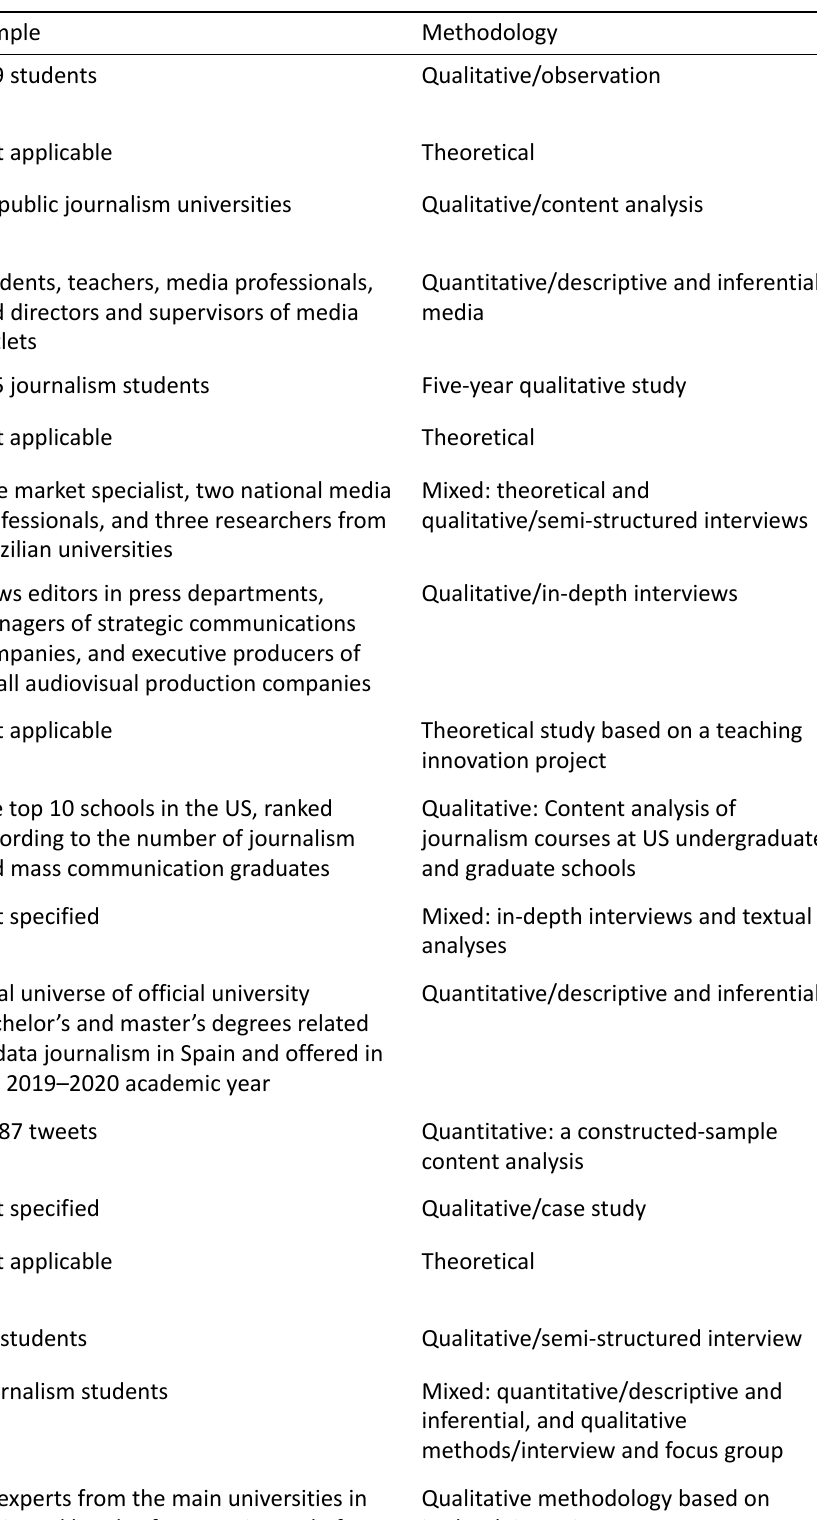
Table 2. (Cont.) Main characteristics of the publications included in the qualitative